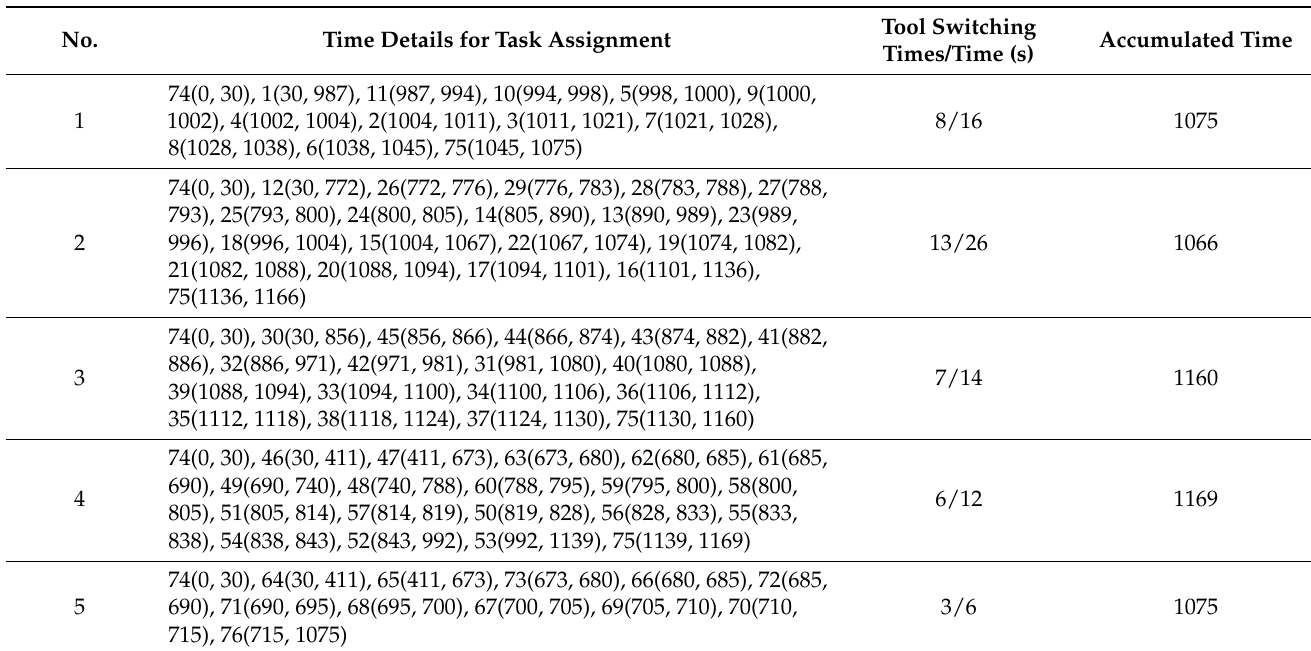
Table 3. Optimization results of ant colony optimization beat 1170 s scheme.